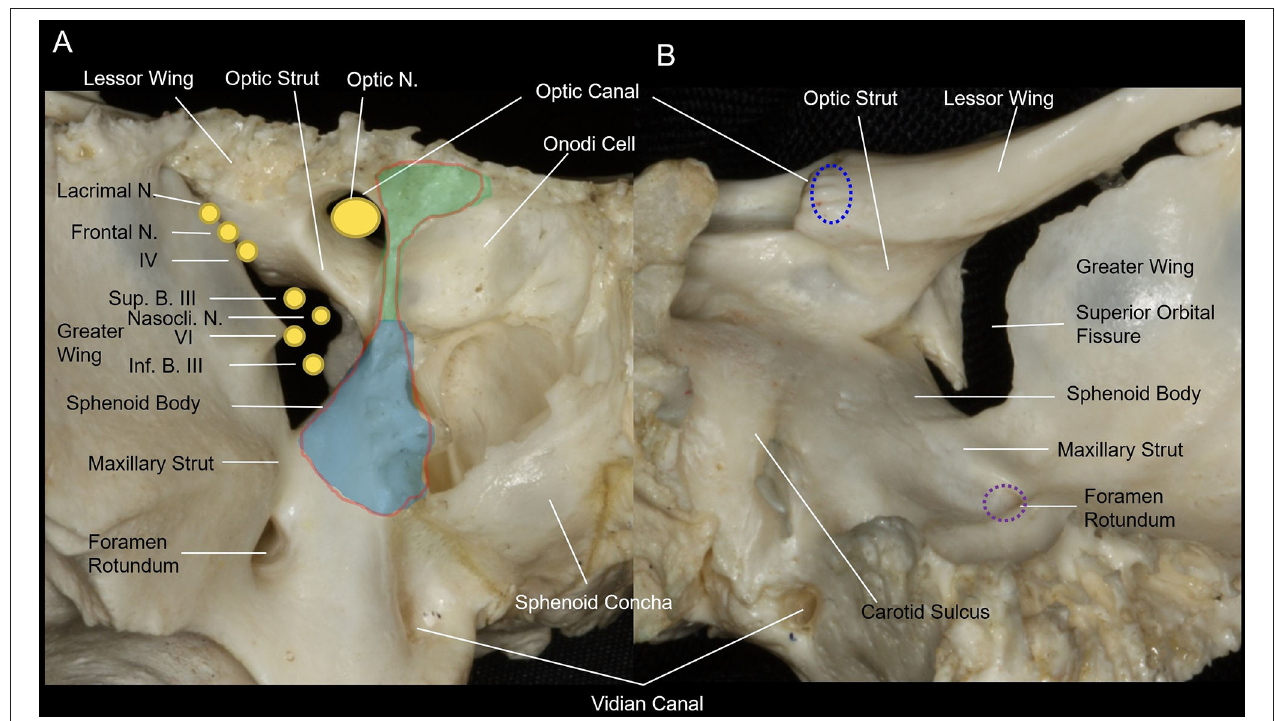
FIGURE 1 | Anterior and posterior views of the osseous anatomy of the orbital apex of the sphenoid bone. (A) Anterior view of the osseous orbital apex of the right side. The osseous optic apex is comprised of the optic canal superomedially and the superior orbital fissure inferolaterally. The medial wall of the orbital apex is a part of the lateral wall of the sphenoid sinus. The contents of the superior orbital fissure are separated from the optic nerve and ophthalmic artery, which pass through the optic canal, by the optic strut superiorly. In addition, they are separated from the maxillary division of the trigeminal nerve that courses by the foramen rotundum by the maxillary strut inferiorly. The endoscopic endonasal approach for optic nerve decompression requires removal of the medial wall of the optic canal from the lateral roof of the sphenoid sinus superiorly to the lateral opticocarotid recess inferiorly, and from the lateral opticocarotid recess posteriorly to the optic tubercle anteriorly (light green area). The endoscopic endonasal approach for decompression of the superior orbital fissure requires removal of the medial wall of the superior orbital fissure, from the lateral opticocarotid recess superiorly to the maxillary strut inferiorly and from the cavernous sinus posteriorly to the junction of the sphenoid sinus and the posterior ethmoid sinus anteriorly (light blue area). The endoscopic endonasal approach for decompression of the orbital apex requires removal of the medial wall of the optic canal and the medial wall of the superior orbital fissure (red outline area). (B) Posterior view of the osseous orbital apex of the right side. The optic nerve and ophthalmic artery, which pass through the optic canal, are separated from the contents of the superior orbital fissure by the optic strut superiorly; and the maxillary division of the trigeminal nerve, which courses by the foramen rotundum, is separated from the contents of the superior orbital fissure by the maxillary strut inferiorly. The lower margin of the fissure is formed by the junction of the greater wing with the body of the sphenoid and is located at the level of the lower edge of the cavernous sinus and the floor of the middle